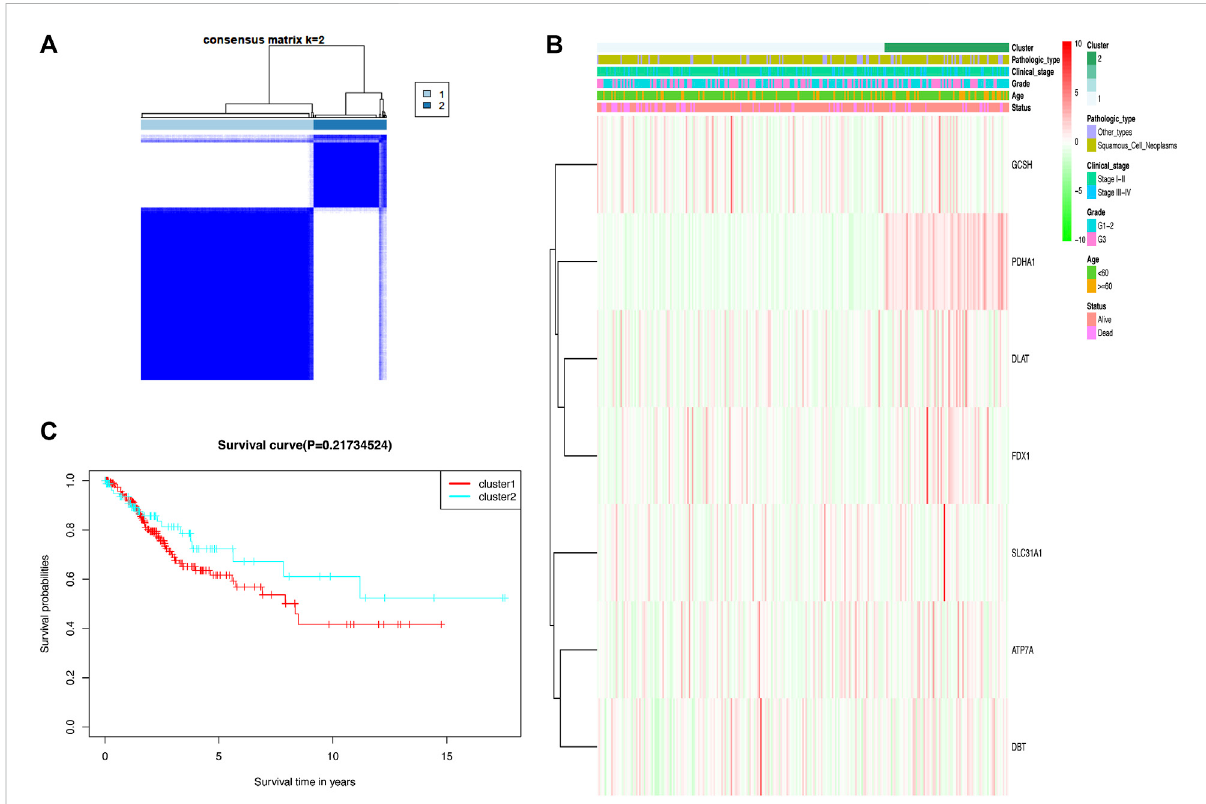
FIGURE 3 Twoclustersbasedonconsensusclusteringofcuproptosis-relatedGenes. (A) Consensusclusteringmatrixfor k =2;atotalof306patientswith cervical cancer were grouped into two clusters. (B) Clinicopathologic features of the two clusters based on differentially expressed cuproptosis- related genes. (C) Kaplan – Meier survival curves for patients in the two